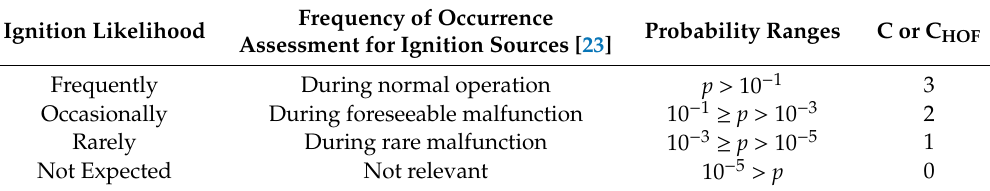
Table 8. Linking probability ranges with the ignition likelihood.